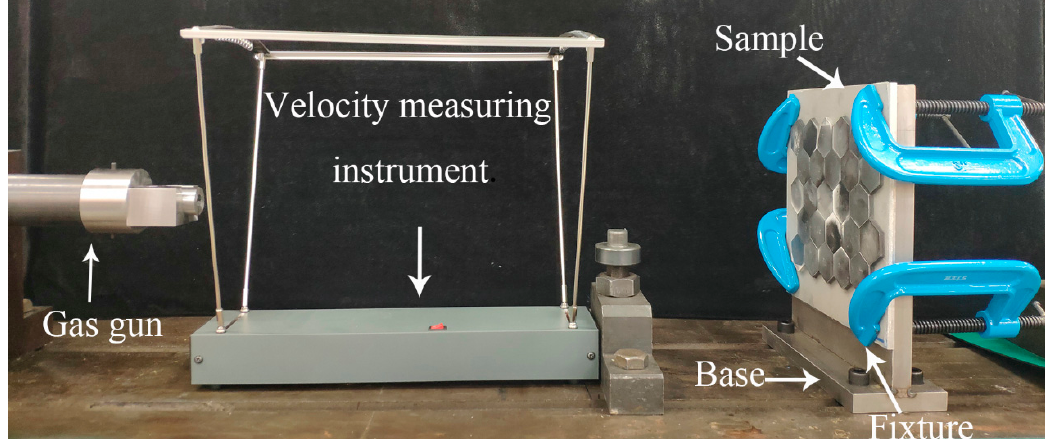
Figure 2. Front view of the three structures: ( a ) Structure 1; ( b ) Structure 2; ( c ) Structure 3.